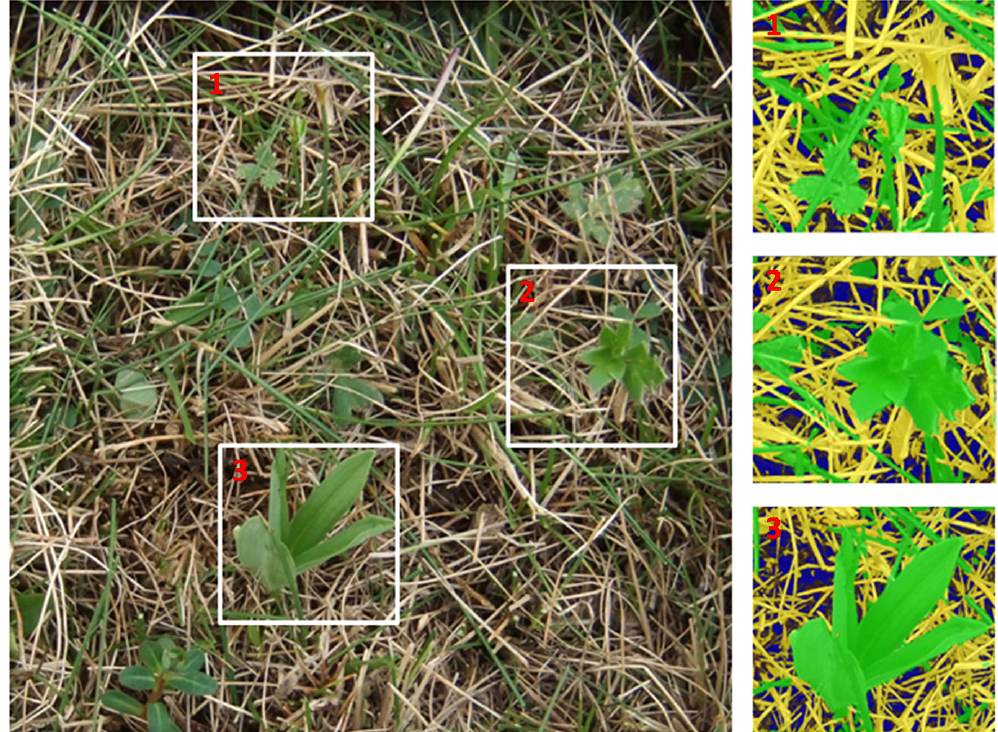
Figure 4. A photo taken on the ground (left) and three examples (white rectangles) of green vegetation (green) classification (1–3 on the